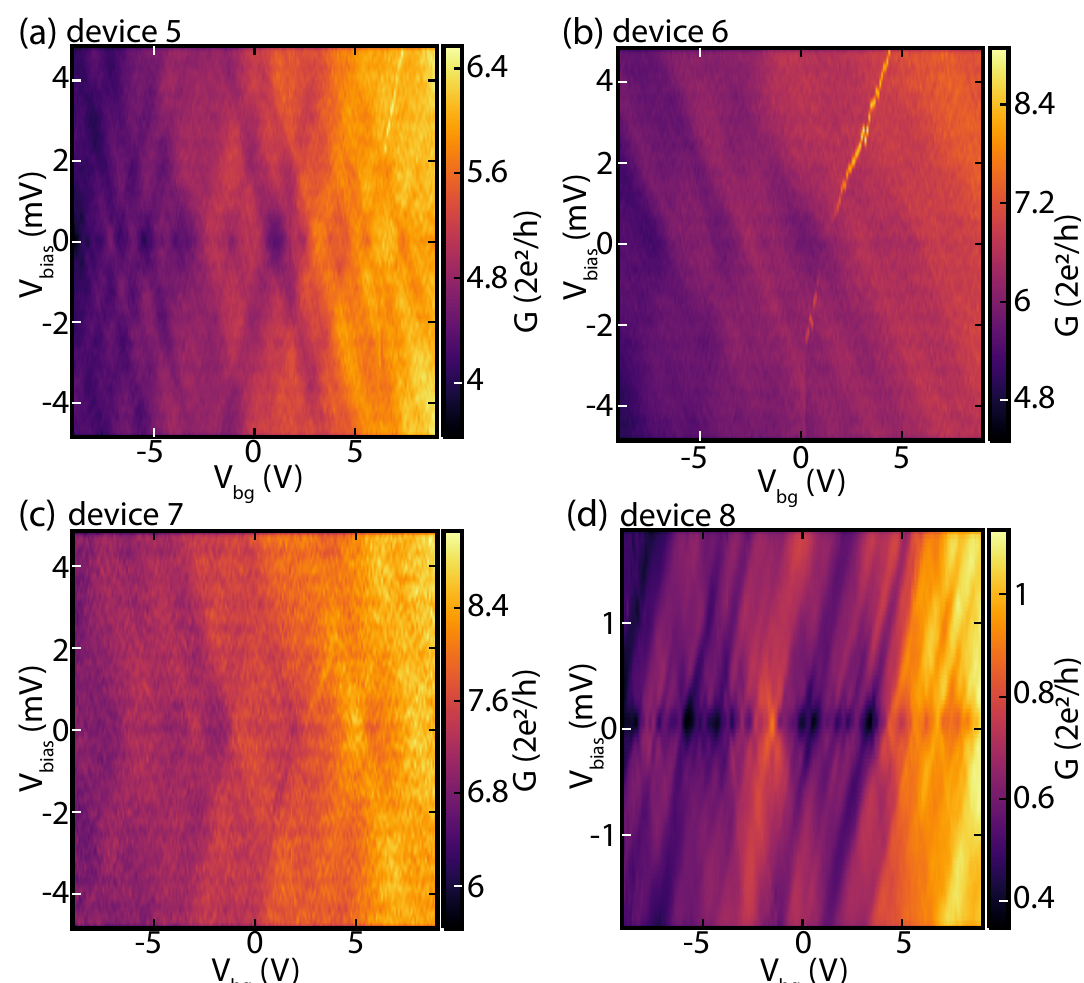
Figure S9: Data from four devices fabricated without a top gate, and only tunable by a back gate. In these devices it was not possible to reach the pinched-off regime with the chemical potential in the bandgap, all data are on the electron side. a is from device 5, b is from device 6, c is from device 7, d is from device 8. In the open regime we see a picture similar to quantum dot behavior in topgate devices, but with broadened resonances. They can be interpreted as Fabry-Perot modes in the nanowire, but evolve continuously into single orbital quantum levels such as in Fig. 2 when the gate potentials are decreased, and the resonances sharpen. B = 0T. Conductance is calculated by numerically diffentiating DC current evolution in bias